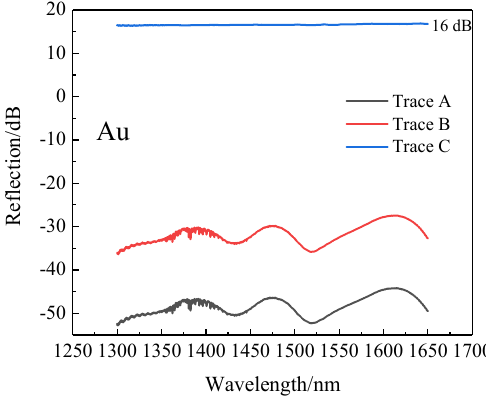
Figure 14. Original spectra with or without metal film. Trace A: without gold film, Trace B: with gold film, Trace C was calculated as Trace B minus Trace A.